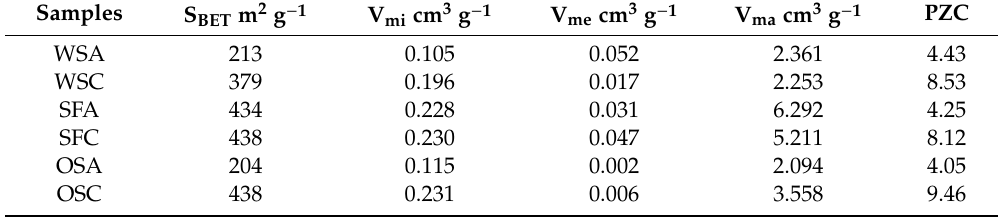
Table 2. Textural parameters and point of zero charge of the adsorbents [11].